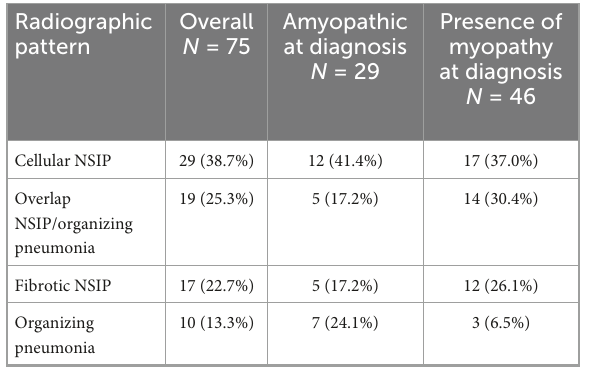
TABLE 3 Radiographic patterns identified in the